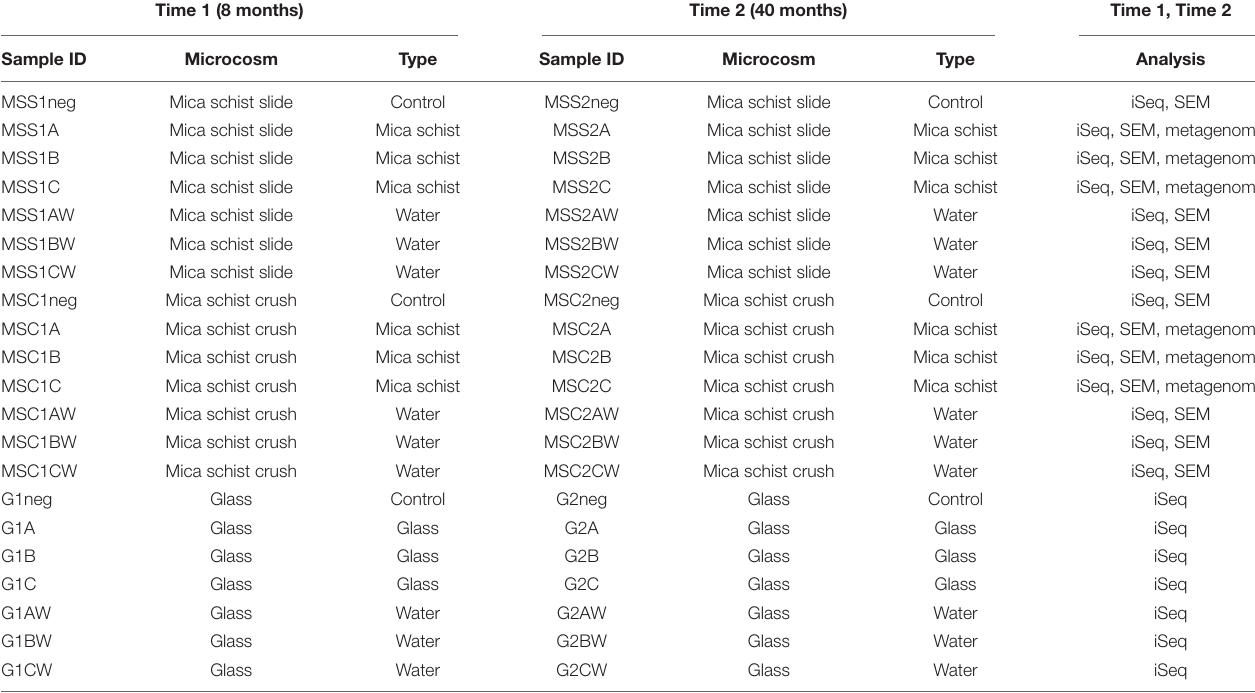
TABLE 1 | List of samples and their Sample IDs, type of microcosm, incubation time point, and sample